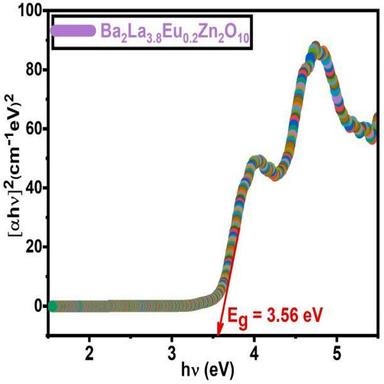
Tauc's plot to determine band-gap (Eg) for optimized nanophosphor Ba2La3.8Eu0.2Zn2O10.